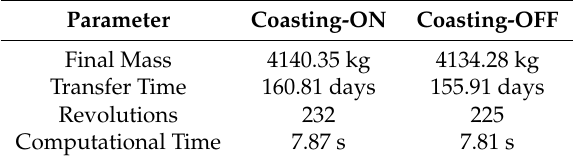
Table 1. Algorithm performance comparison for coasting ON/OFF modes for GTO to GEO